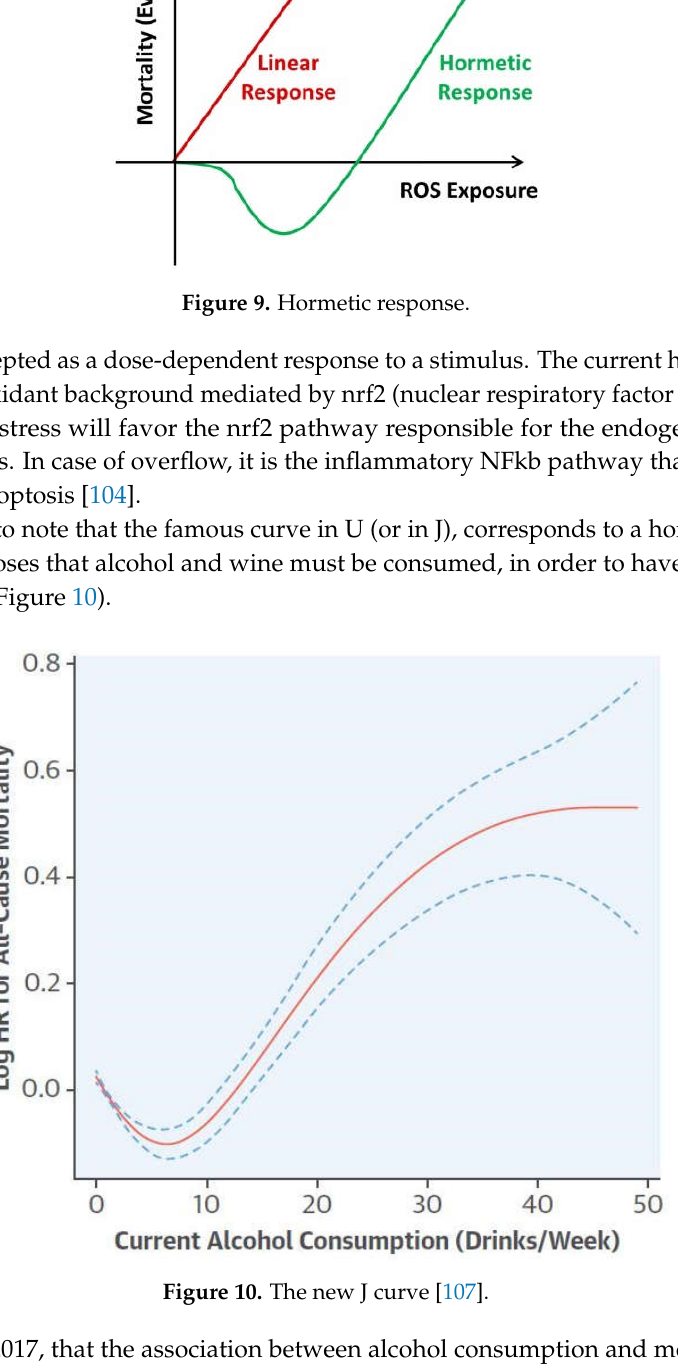
Figure 10. The new J curve [107].